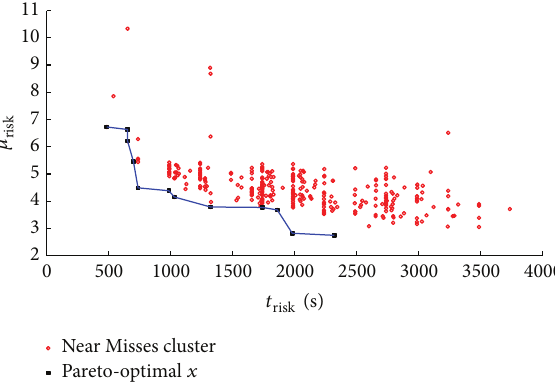
Figure 14: Pareto front for the cluster of Near Misses.